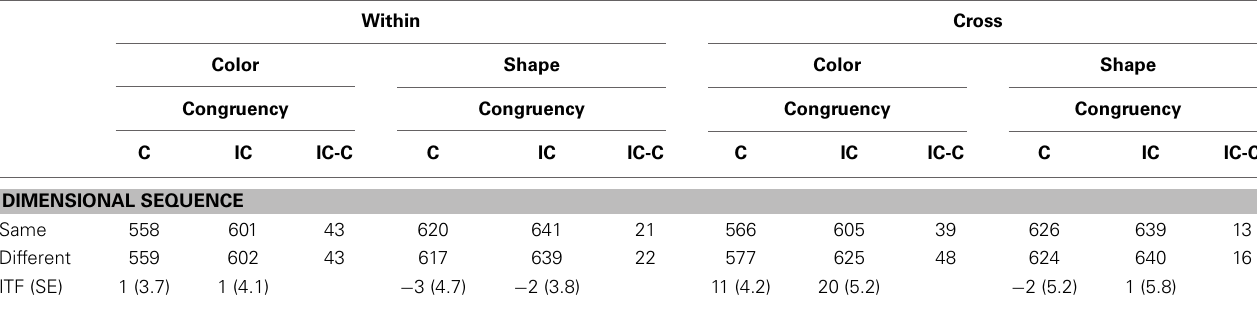
Table 3 | Mean correct reaction times in trial n as a function of the dimensional sequence of target-defining feature with trial n − 1 and the response congruency of trial n in Experiment